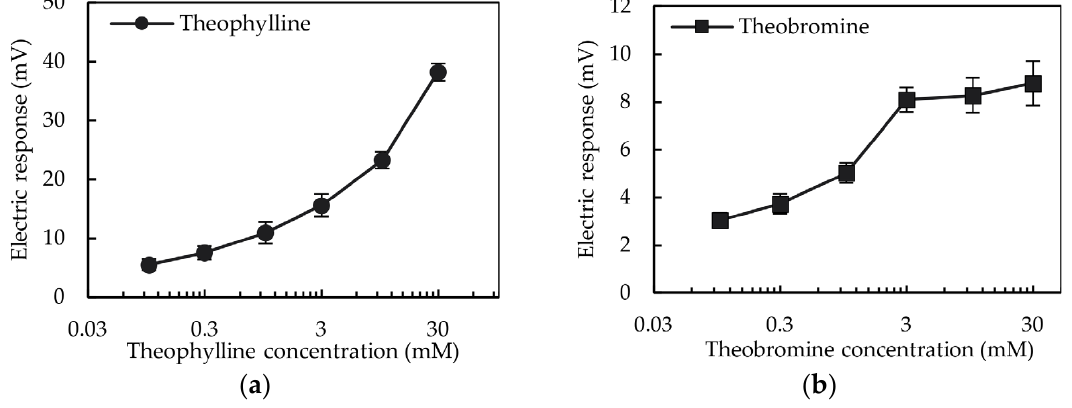
Figure 9. Concentration characteristics of each caffeine analog obtained from taste sensors with the 1 mM TDAB membrane modified with 0.03 wt% 2,6-DHTA: ( a ) Theophylline; ( b ) theobromine. The error bar indicates the SD of data, n = 8 (electrode) × 1 (rotation) = 8 values.